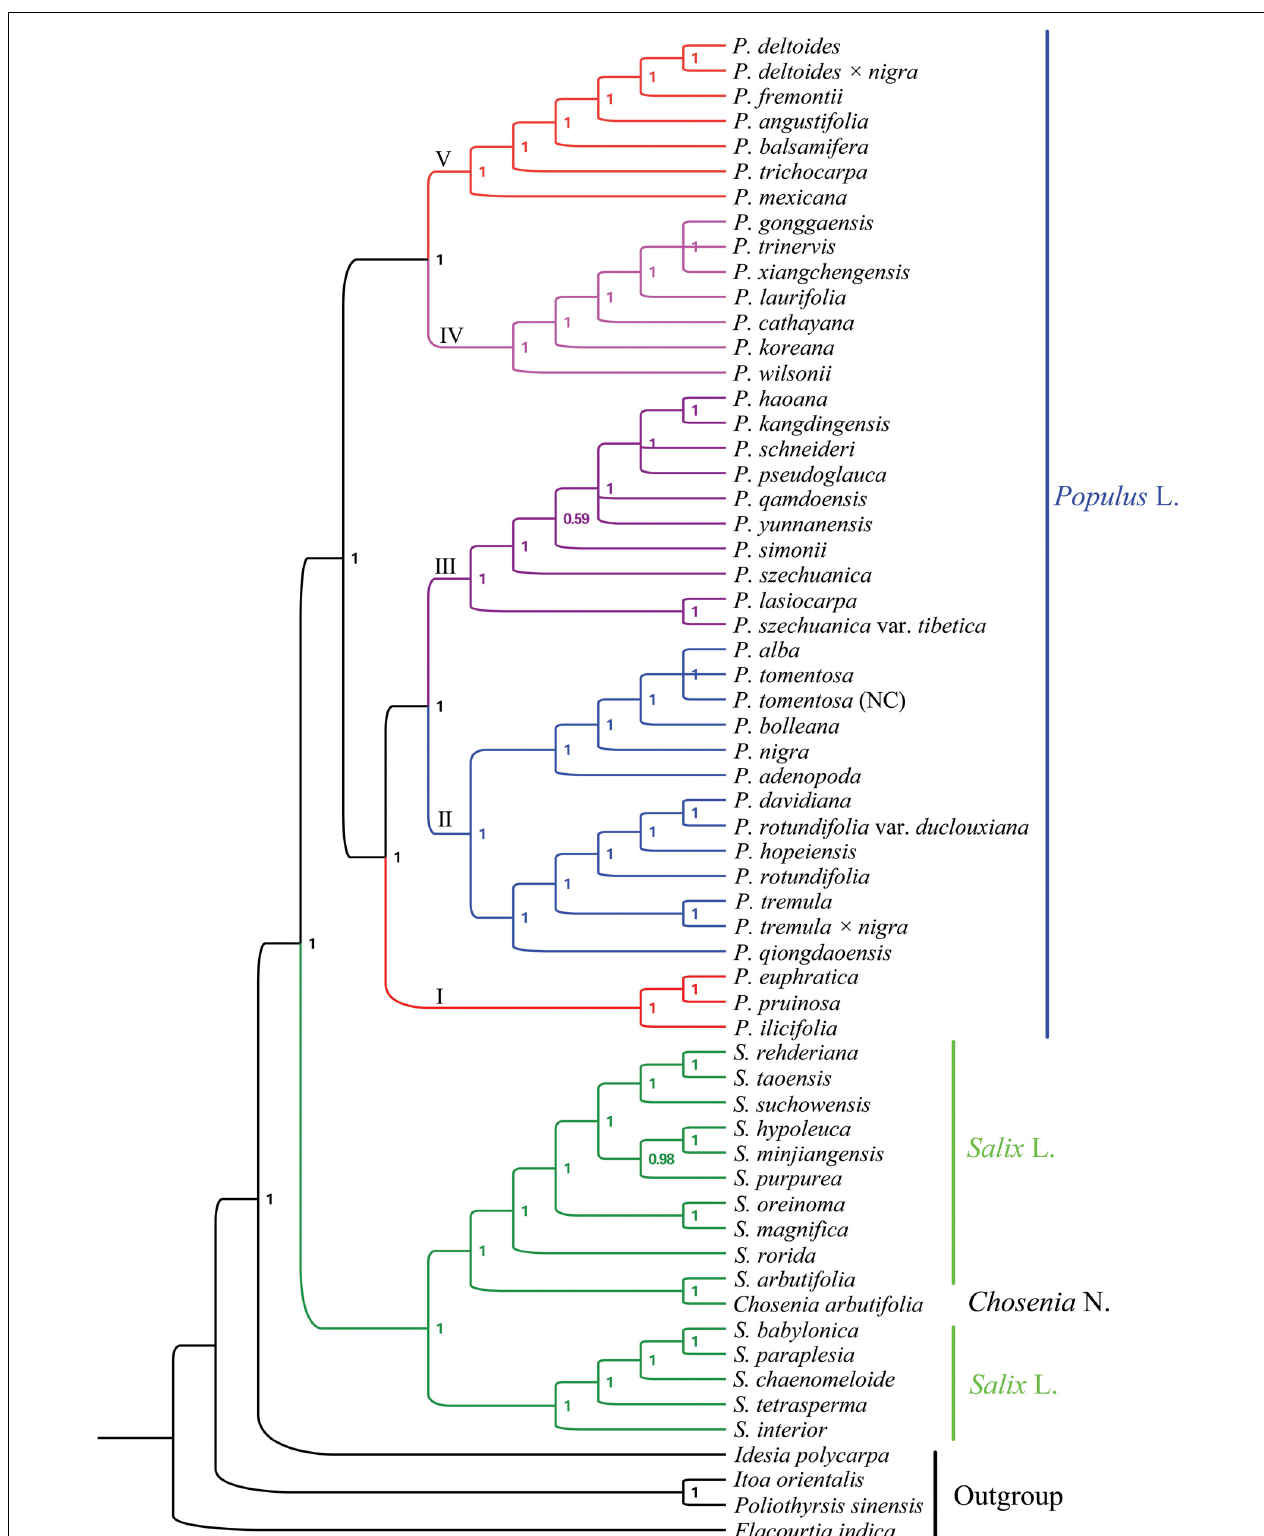
FIGURE 5 | Phylogenetic tree reconstructions of Populus using Bayesian inference (BI) based on whole chloroplast genome sequences.